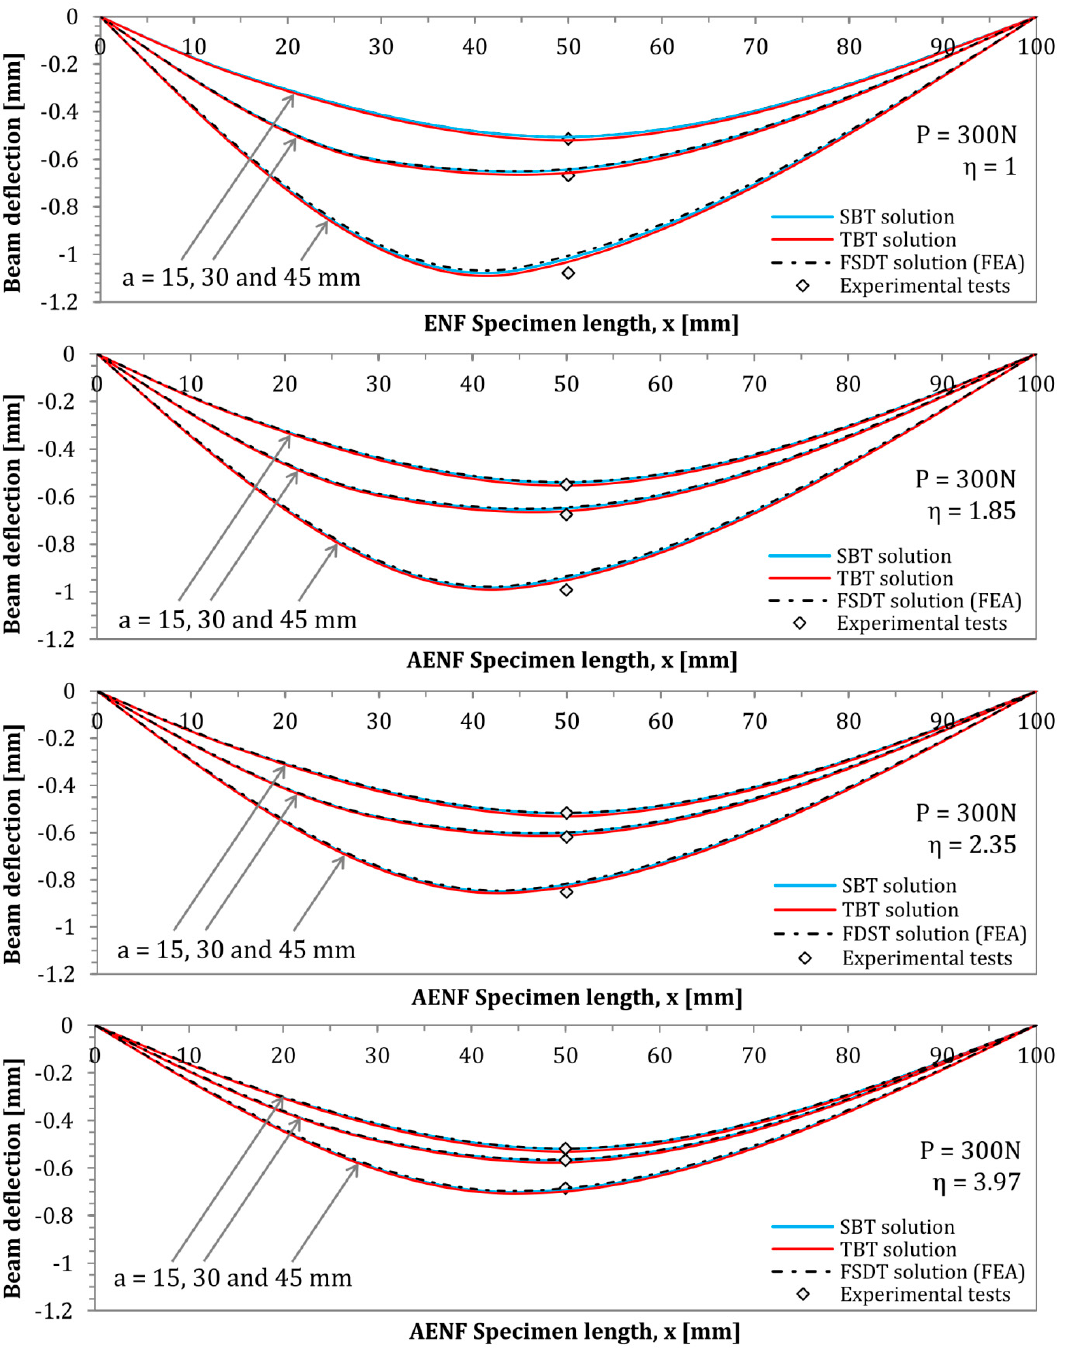
Figure 8. AENF test specimen deflection profiles derived by three different methods and test results.